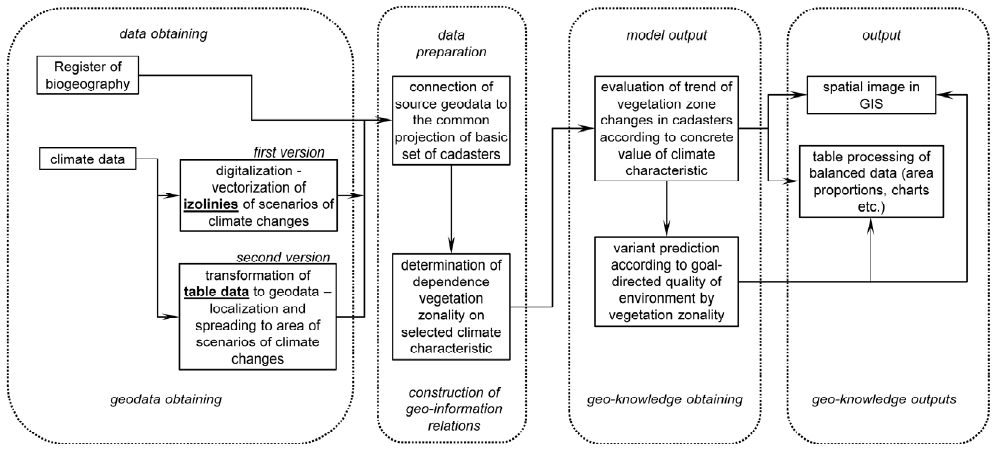
Figure 1. Flowchart of biogeographic envelope for a regional model of climate conditions in vegetation zones of the Czech Republic